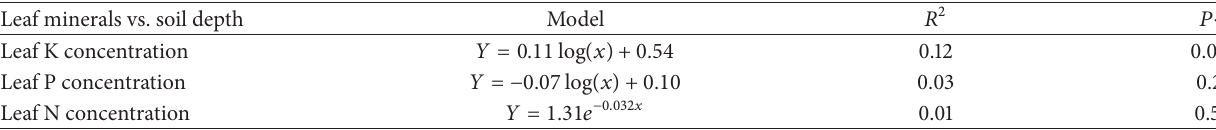
Table 5: Regressions between olive leaf primary macronutrient concentrations (𝑌) and soil depth (𝑥) . Coefficients of determination (𝑅 2 ) and statistical significance (𝑃) are also presented. Models are sorted in descending order of 𝑅 2 .